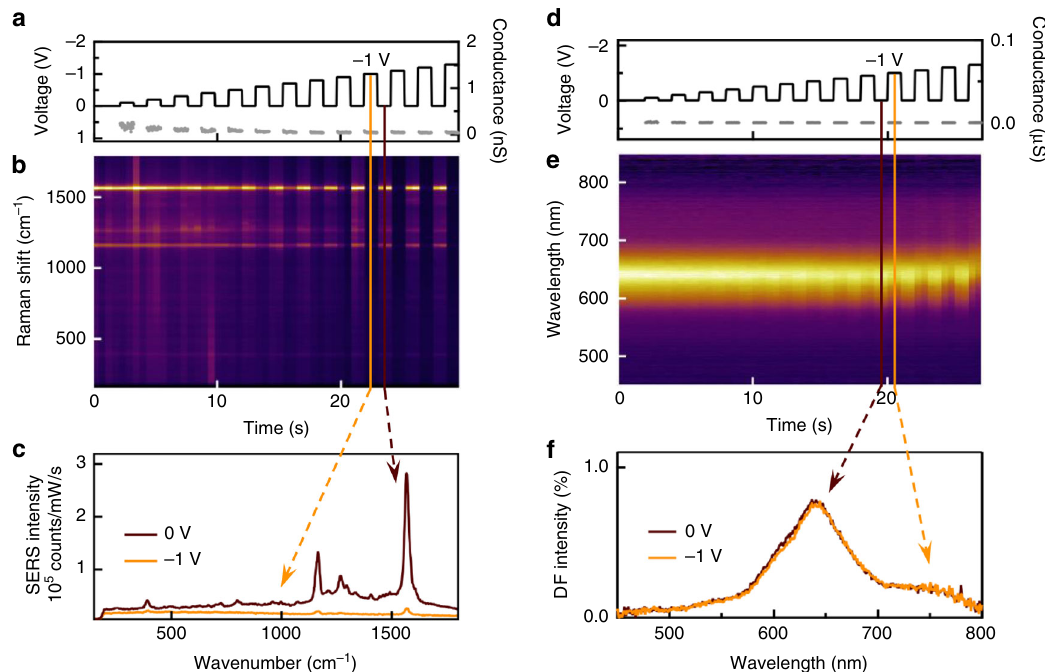
Fig. 2 Raman (SERS) and dark- fi eld switching under bias in single junction of BPDT. a , b Real-time SERS for increasingly negative bias voltage. c SERS spectra decrease 10-fold by − 1 V bias. d – f Dark- fi eld scattering intensity under bias, with decrease in amplitude and coupled plasmon redshift for j V j > 1 V but f no change for − 1 V